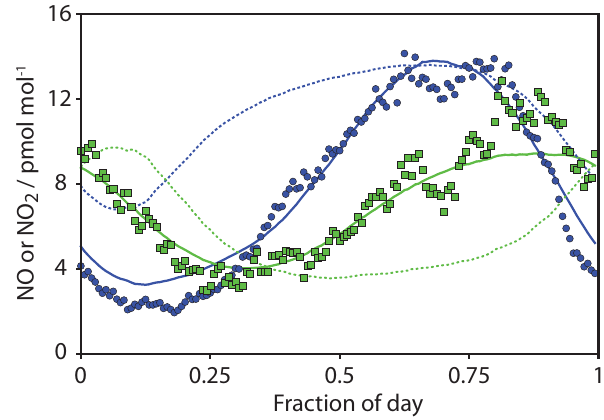
Fig. 4. Mean diurnal measured NO (blue circles) and NO 2 (green squares) together with modelled equivalents under case B1 (bro- ken lines; no halogen chemistry) and case B2 (solid lines; halogen source added). In each case the model NO x source strength was empirically optimised to replicate the peak NO